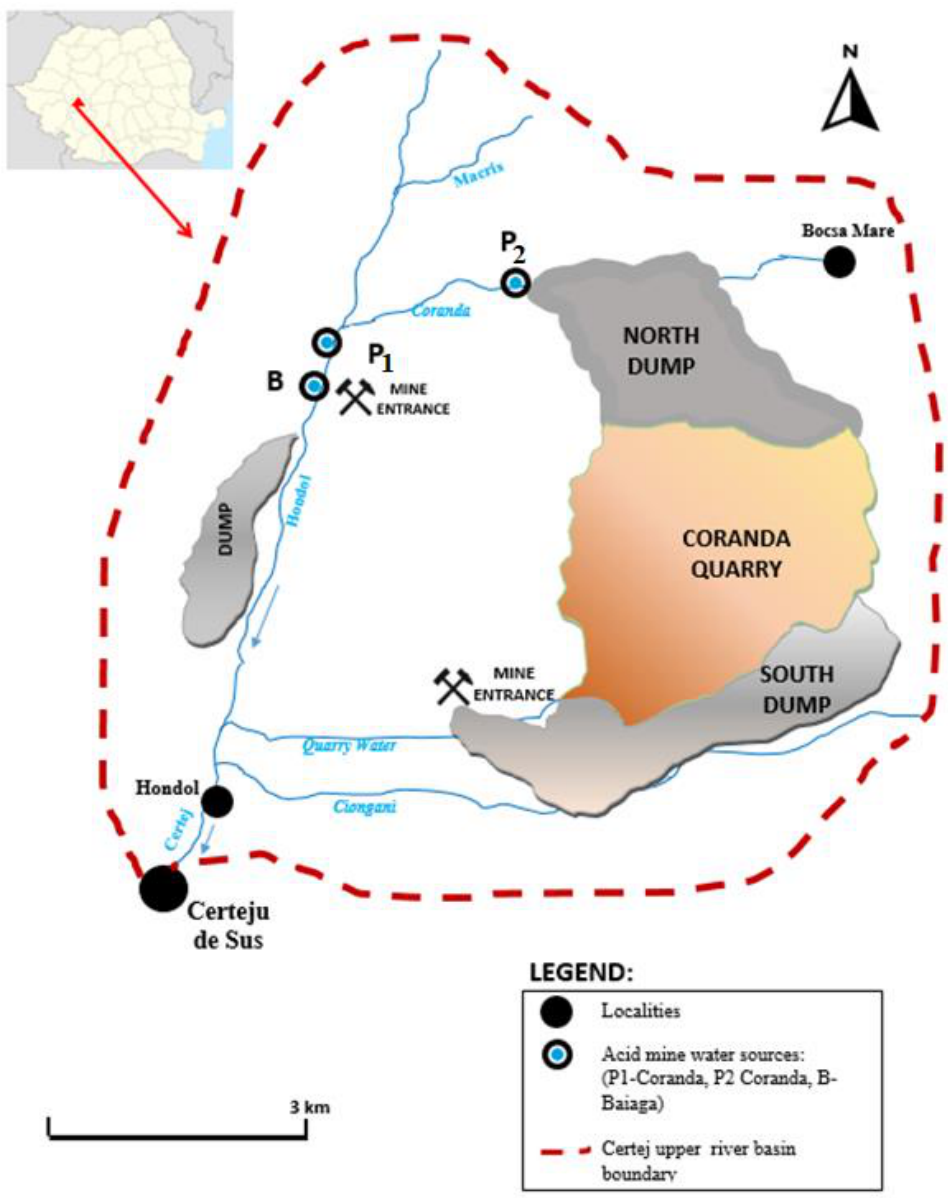
Figure 1. Map of the Certej